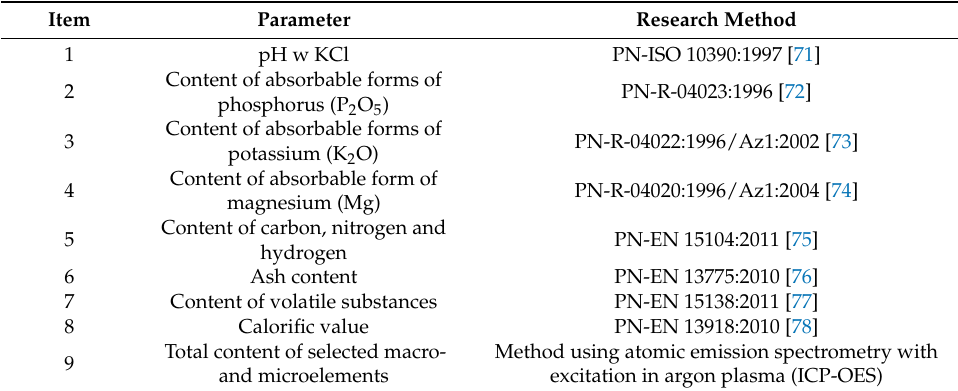
Table 7. Parameters analysed with research